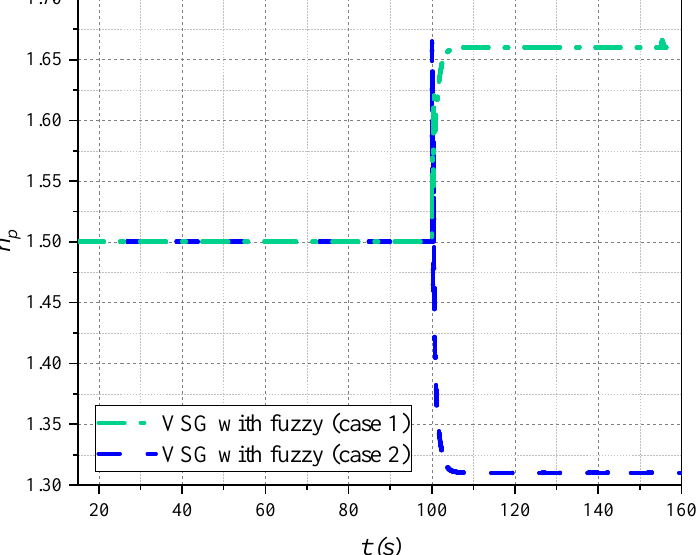
Figure 27. Predicted microgrid load n p value for the scenario presented in Section